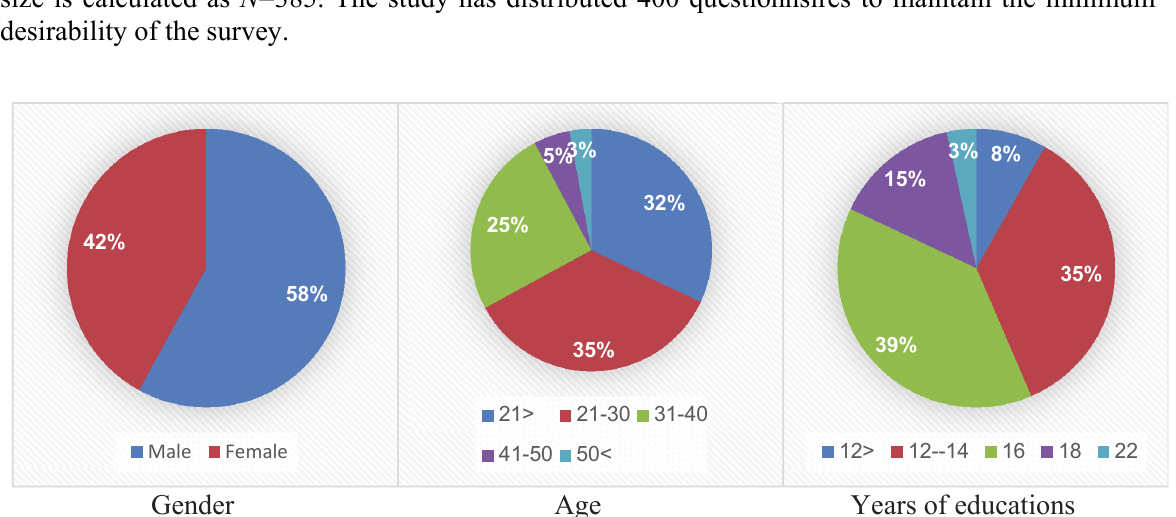
Fig. 1. Personal characteristics of the